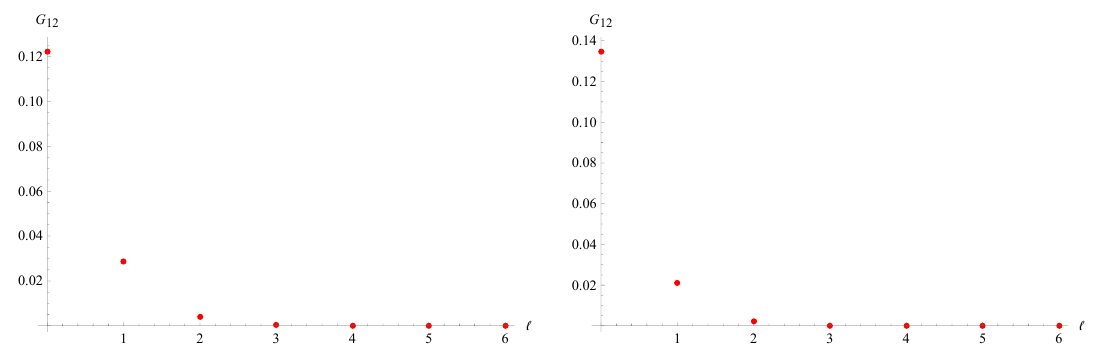
Figure 8 . Left: the 1 (cid:0) 2 correlator with m = 1 ; B = 1 as a function of l (irrelevant operator). Right: the relevant case m 2 = (cid:0) 1, B = 1. They drop to zero in the UV with a scale depending on the wormhole size as well as in the conformal dimension of the perturbing operator. In the IR they approach a (cid:12)nite